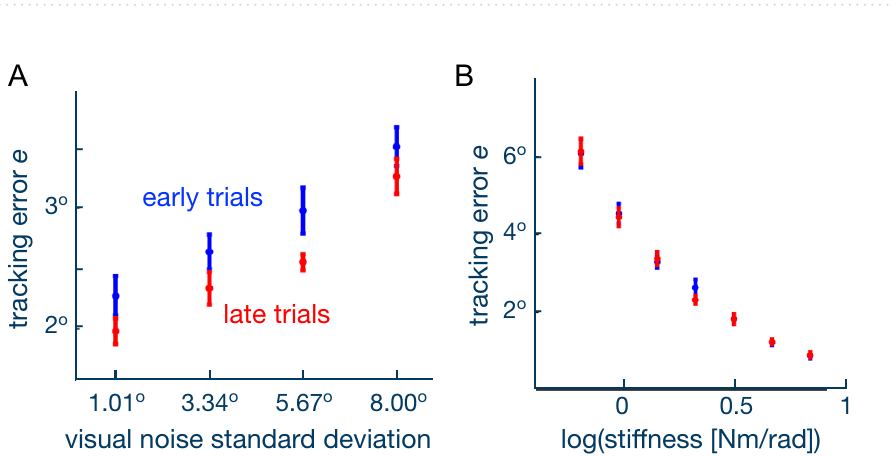
Figure 2. Tracking error and muscle cocontraction adapted with practice. The figures shows the mean values with standard error bar over all trials of each subject in the corresponding block. ( A ) The population mean tracking error and the associated variability decreased with trials for every level of visual noise. ( B ) The normalised cocontraction was initially large in the first block of trials for all visual noise conditions and decreased with practise. The level to which the cocontraction converged increases with the visual noise imposed on the target.